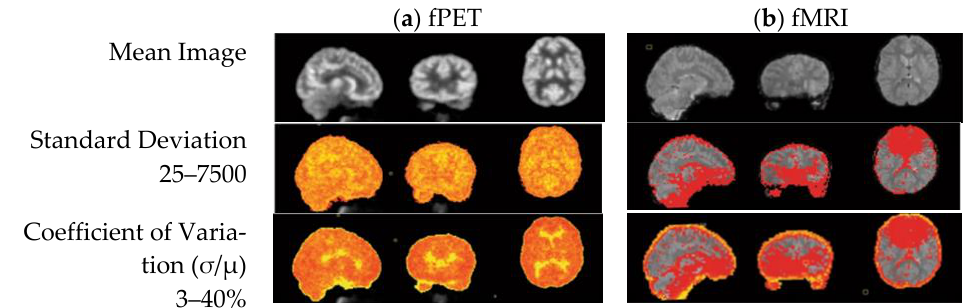
Figure 4. Raw images of fPET and fMRI scans [288].